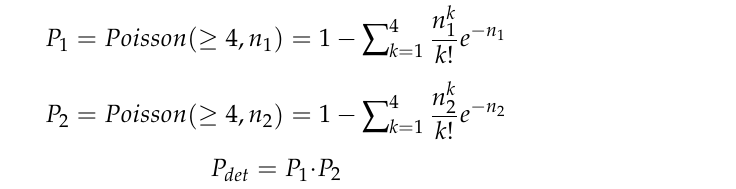
Figure 5. Detection efficiency of a gamma-ray as a function of the impact position on an 80 cm long fiber, calculated as the product of the probabilities of getting at least four photons detected on each SiPM. ( a ) When the gamma-ray deposits 100 keV. ( b ) When the gamma-ray deposits 200 keV.